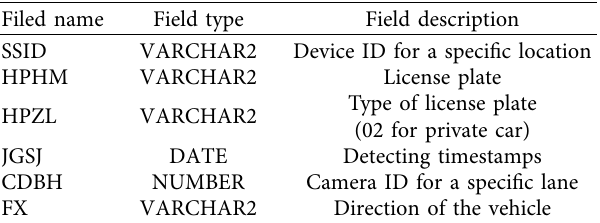
Table 1: AVI data fields